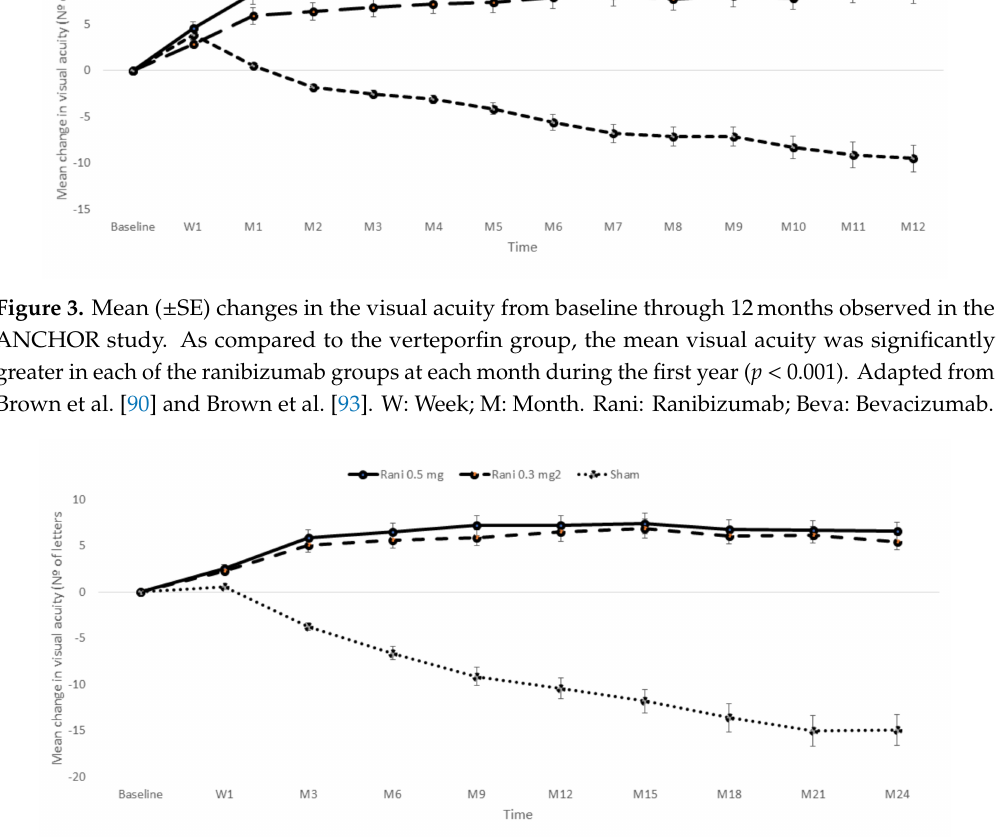
Figure 4. Mean ( ± SE) changes in the visual acuity from baseline through 24months observed in the MARINA study. As compared to the sham injection group, the mean visual acuity was significantly greater in each of the ranibizumab groups at each month during the study follow-up ( p < 0.001). At week 1, On day, p = 0.006 for patients receiving ranibizumab 0.3 mg and p = 0.003 for those receiving ranibizumab 0.5 mg. Adapted from Rosenfeld et al. [89]. W: Week; M. Month; Rani: